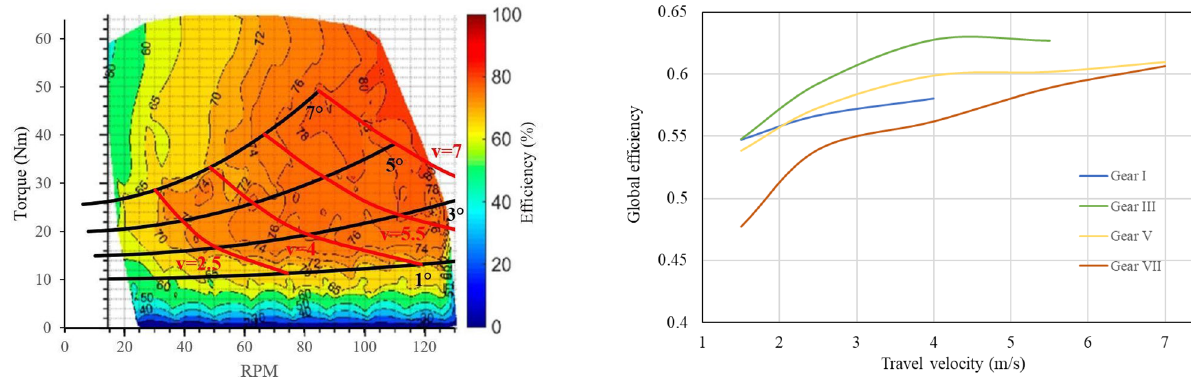
Fig. 15 PU efficiency map with overlaid iso-speed (red) and iso- gear curves (black). Steady-state drive on a flat road